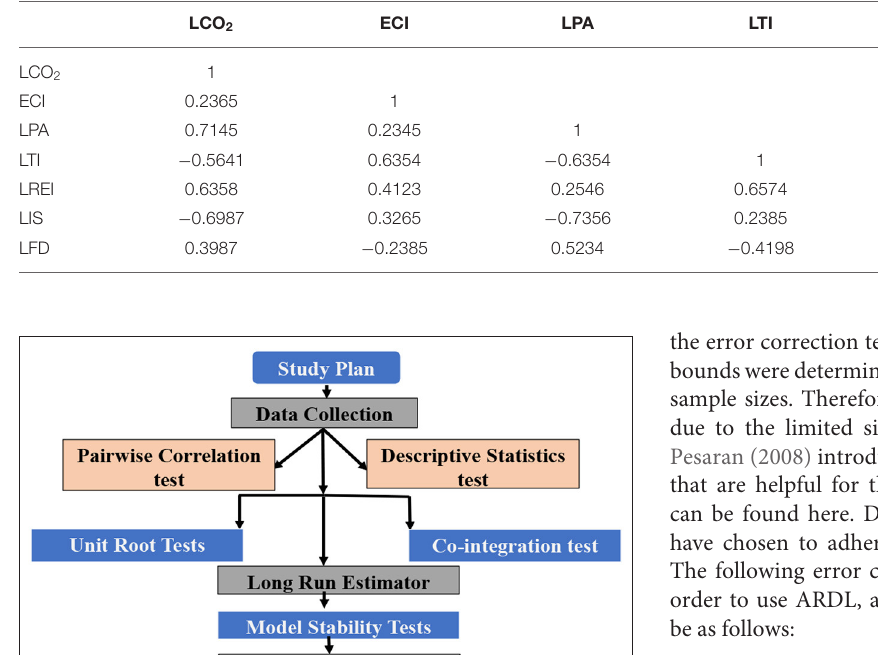
TABLE 3 | Matrix correlation.